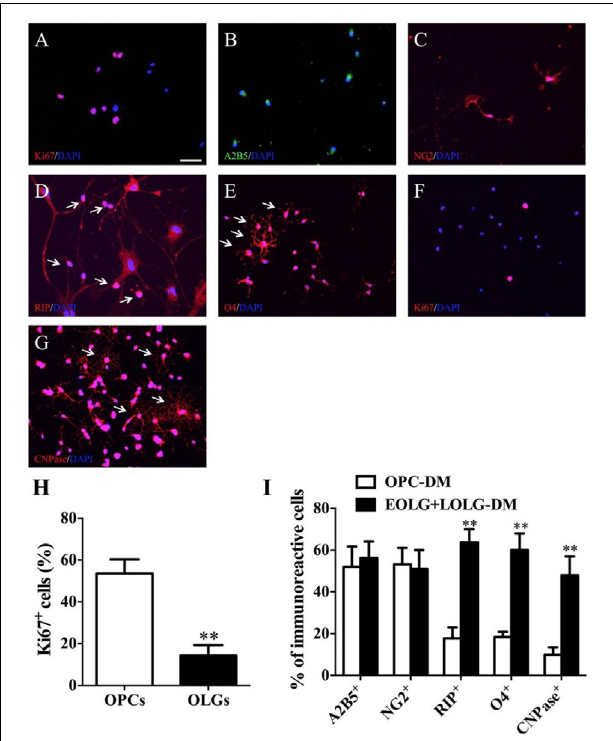
FIGURE 4 | Fundamental steps of BM-NSCs OLGs differentiation. (A) Expression of Ki-67 at day 38, as shown by immunofluorescence analysis. (B , C) Immunofluorescence staining of progenitor cells at day 38, expressing A2B5, and NG2. (D , E) RIP and O4 staining show cells ramified morphology. (F) Expression of Ki-67 which in late stage of OLGs differentiation (day 52). (G) At the end of differentiation stage, CNPase + OLGs show typical ramified morphology. (H) OPCs and OLGs proliferation (A , F) was quantified as percentage of Ki67-positive cells. Scale bar = 50 µ m. (I) The percentages of A2B5 + , NG2 + , RIP + , O4 + , and CNPase + cells are present in EOLG+LOLG-DM cultures as compared to OPC-PM cultures. Data are expressed as the mean ± SD, three independent experiments, ∗∗ p < 0.01, Student’s t -test.